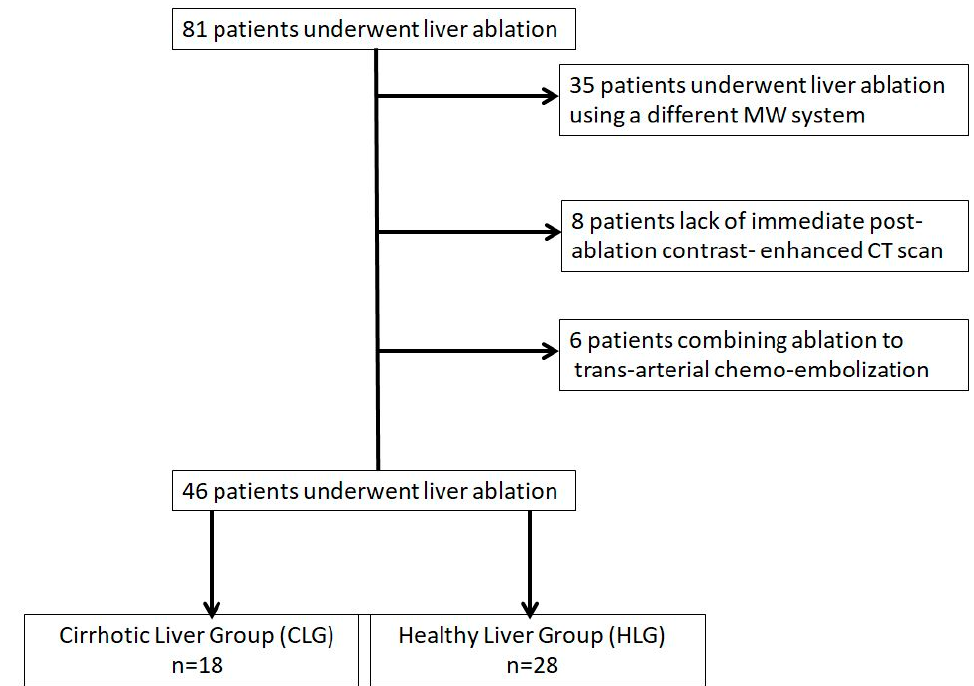
Figure 1. Flow diagram of patient selection for the study .